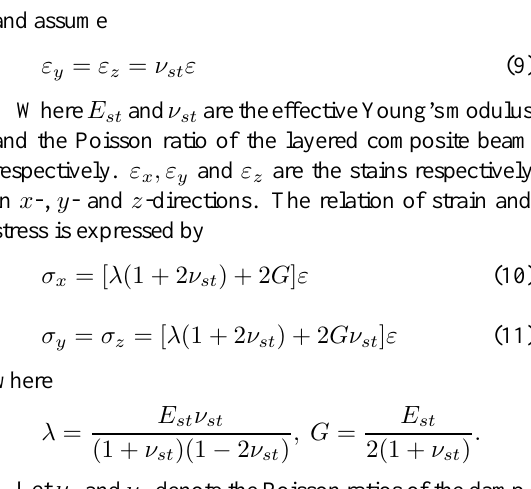
Fig. 1. Description of the problem, layered beam geometry and coordinator